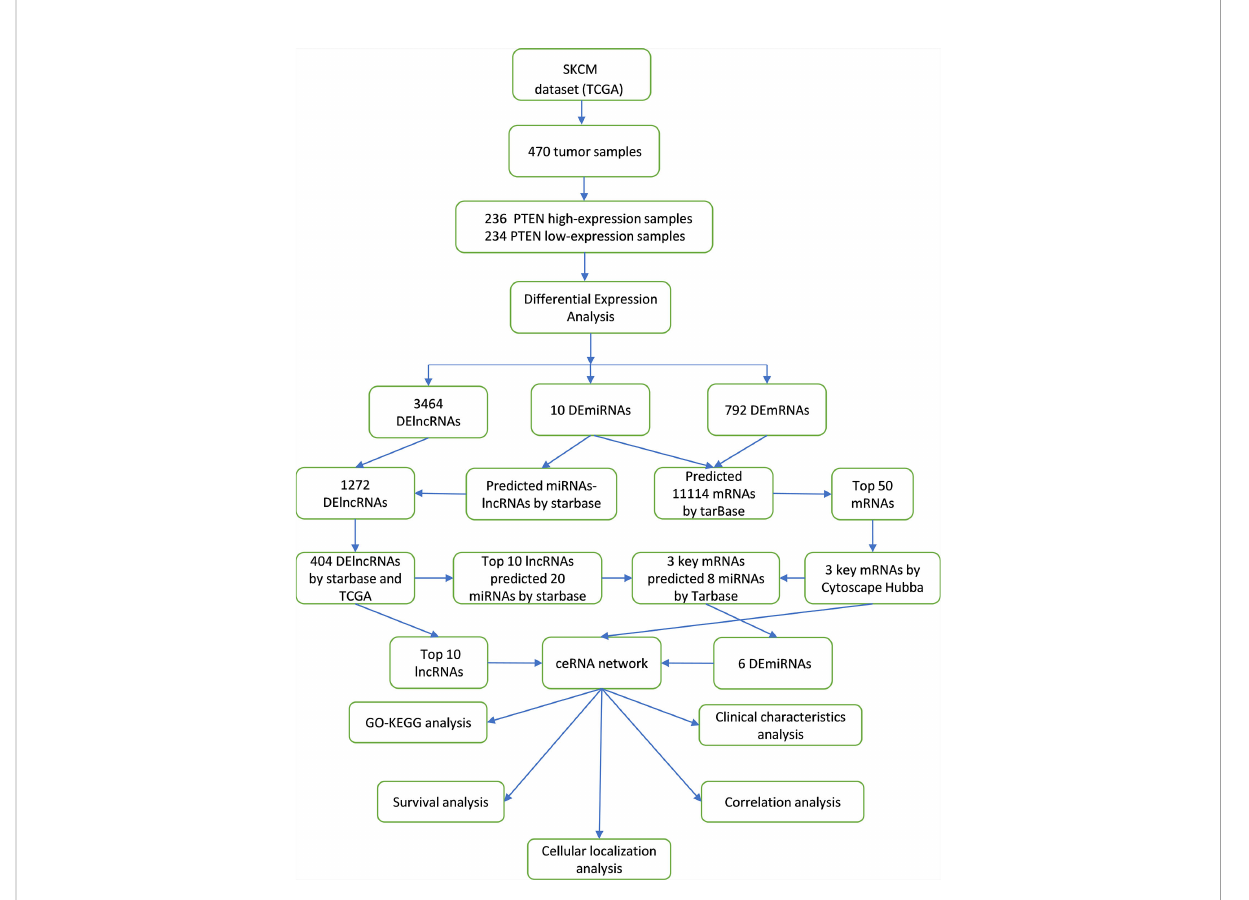
FIGURE 1 Construction and analysis of the ceRNA network in